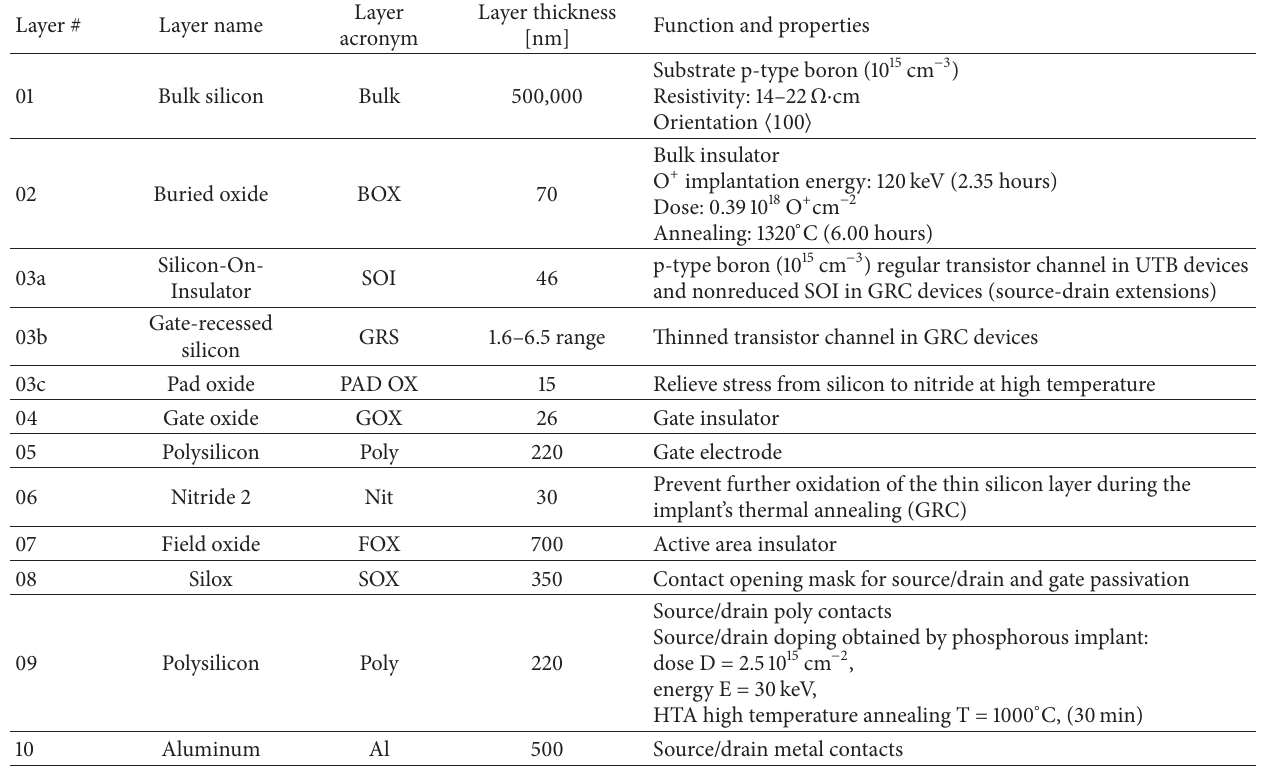
Table 1: Process parameters for deposited layers of fabricated